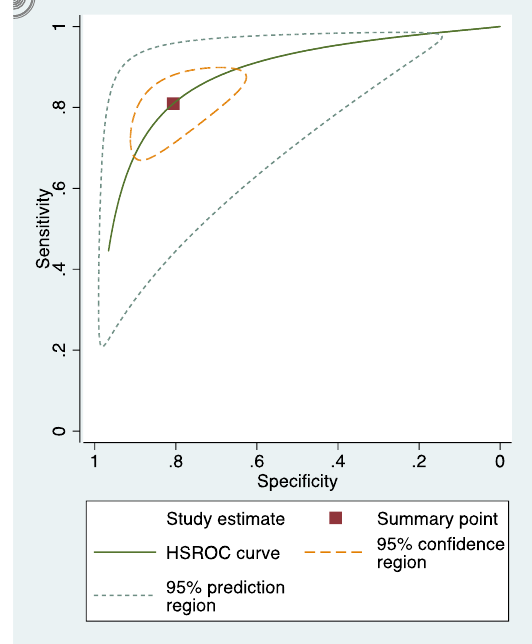
Figure 3. sRoc curves of fluorescence-based methods.